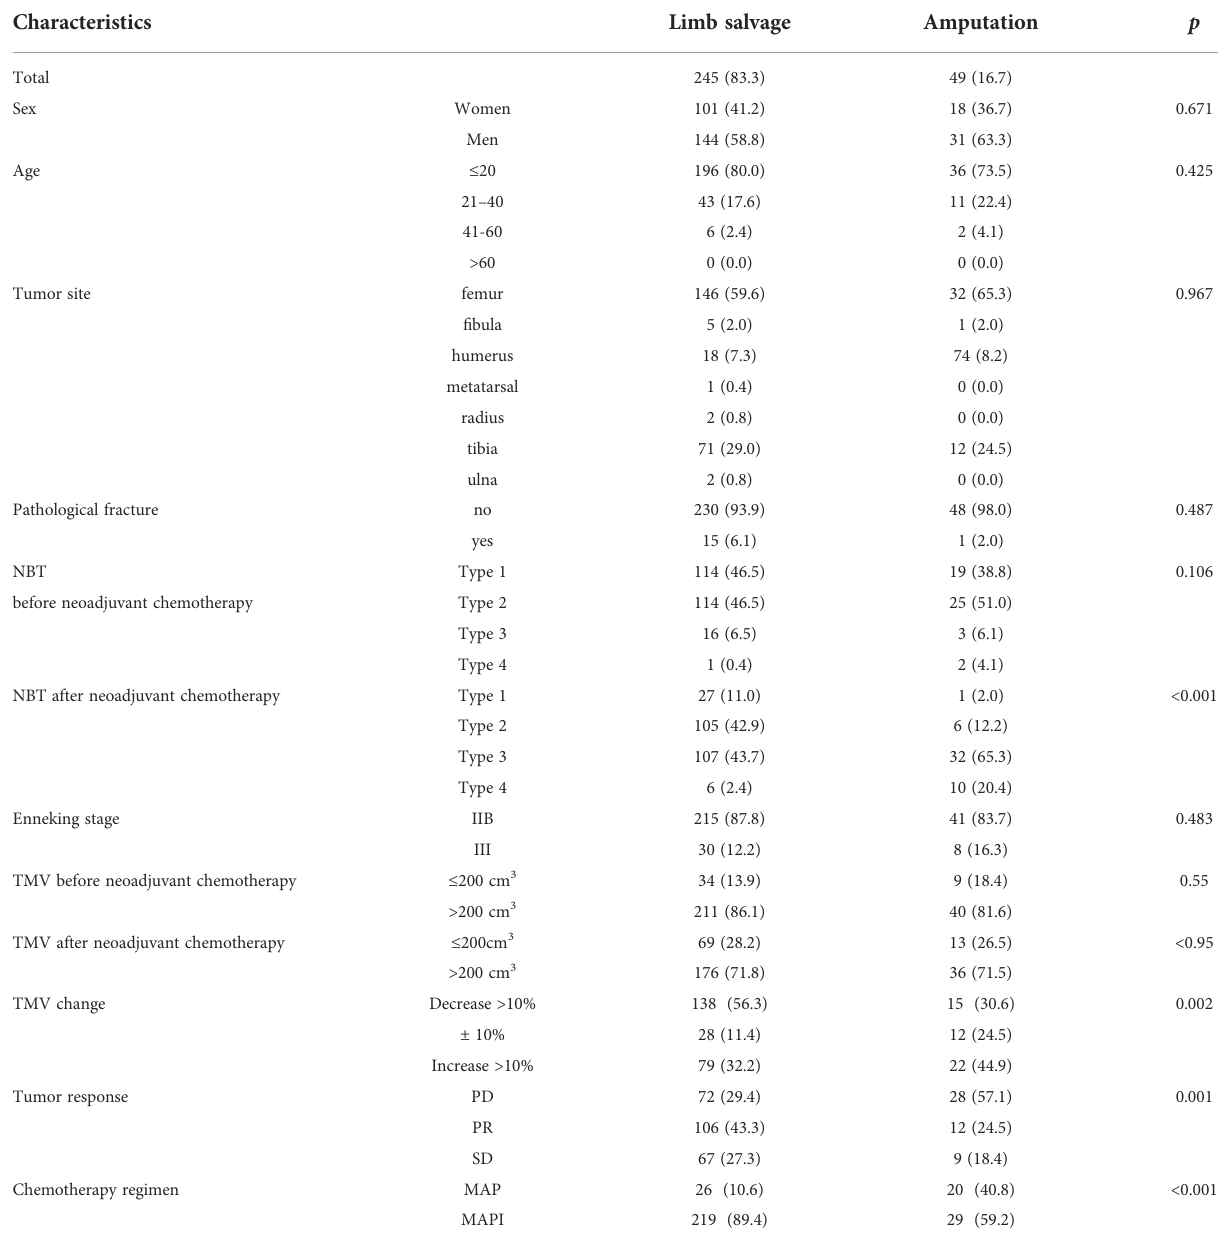
TABLE 1 Clinical characteristics of patients receiving limb salvage versus amputation for